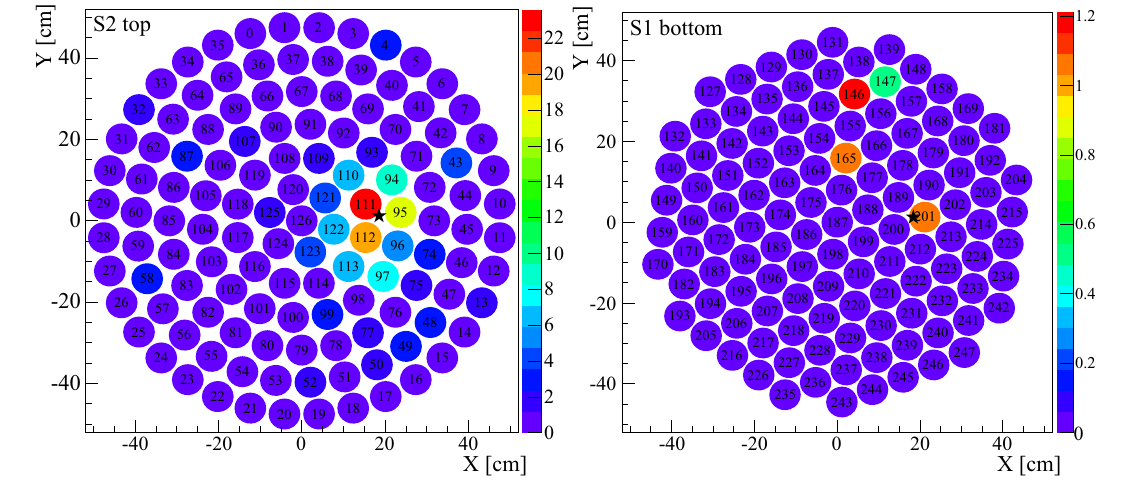
Fig. 17 Distribution of the S2 signal on the top (left) and the S1 signal onthebottomPMTarray(right)oftheeventshowninFig.16.Thecolor scales are given in uncorrected PE. The S2 signal is very localized and